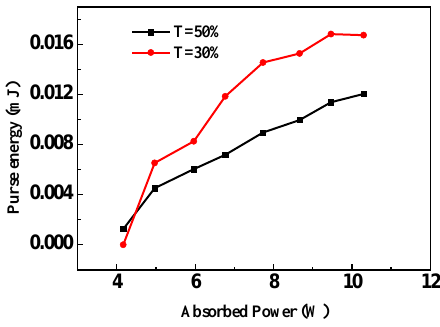
Figure 5. Pulse energy, as a function of absorbed pump power.